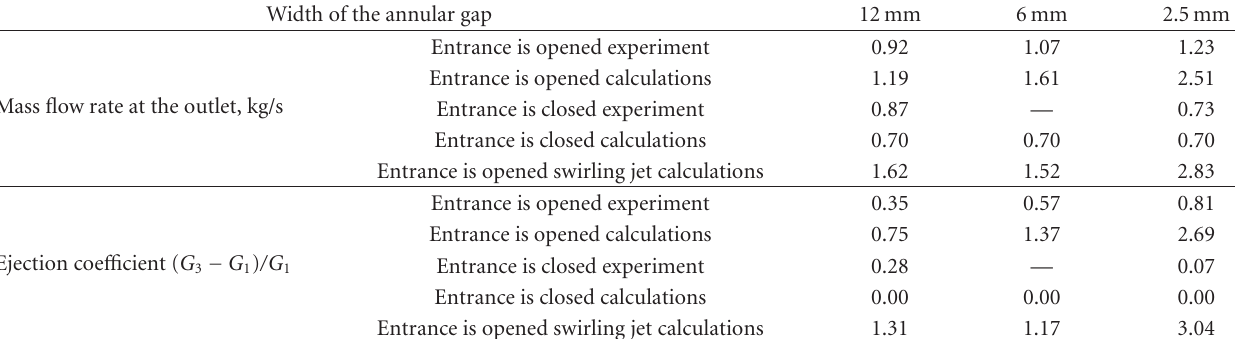
Table 1: Experimental